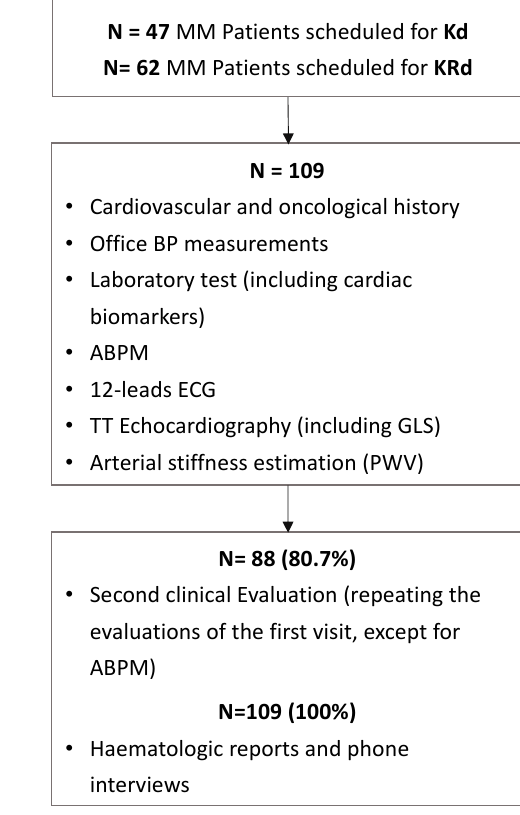
Figure 1. Study protocol.